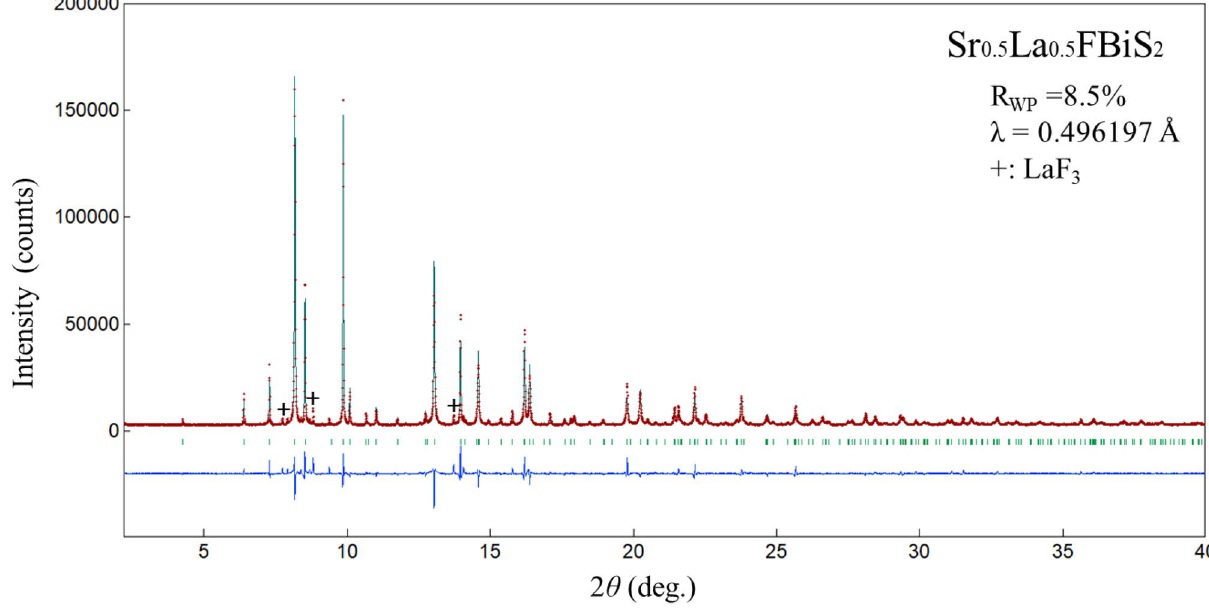
Figure 1. Synchrotron powder XRD patterns for Sr 0.5 La 0.5 FBiS 2 . Symbol of + indicates the impurity of LaF 3